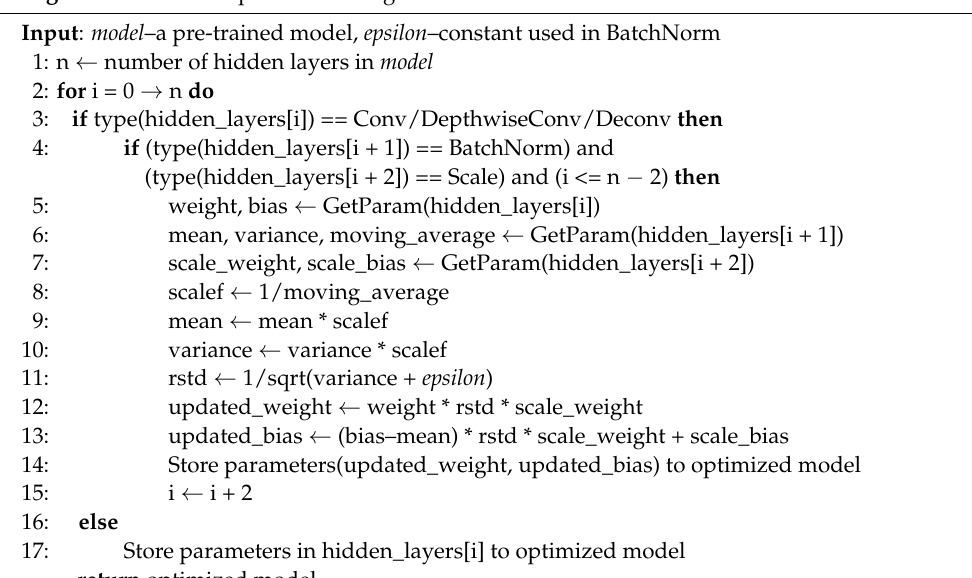
Algorithm 1 Model Optimization